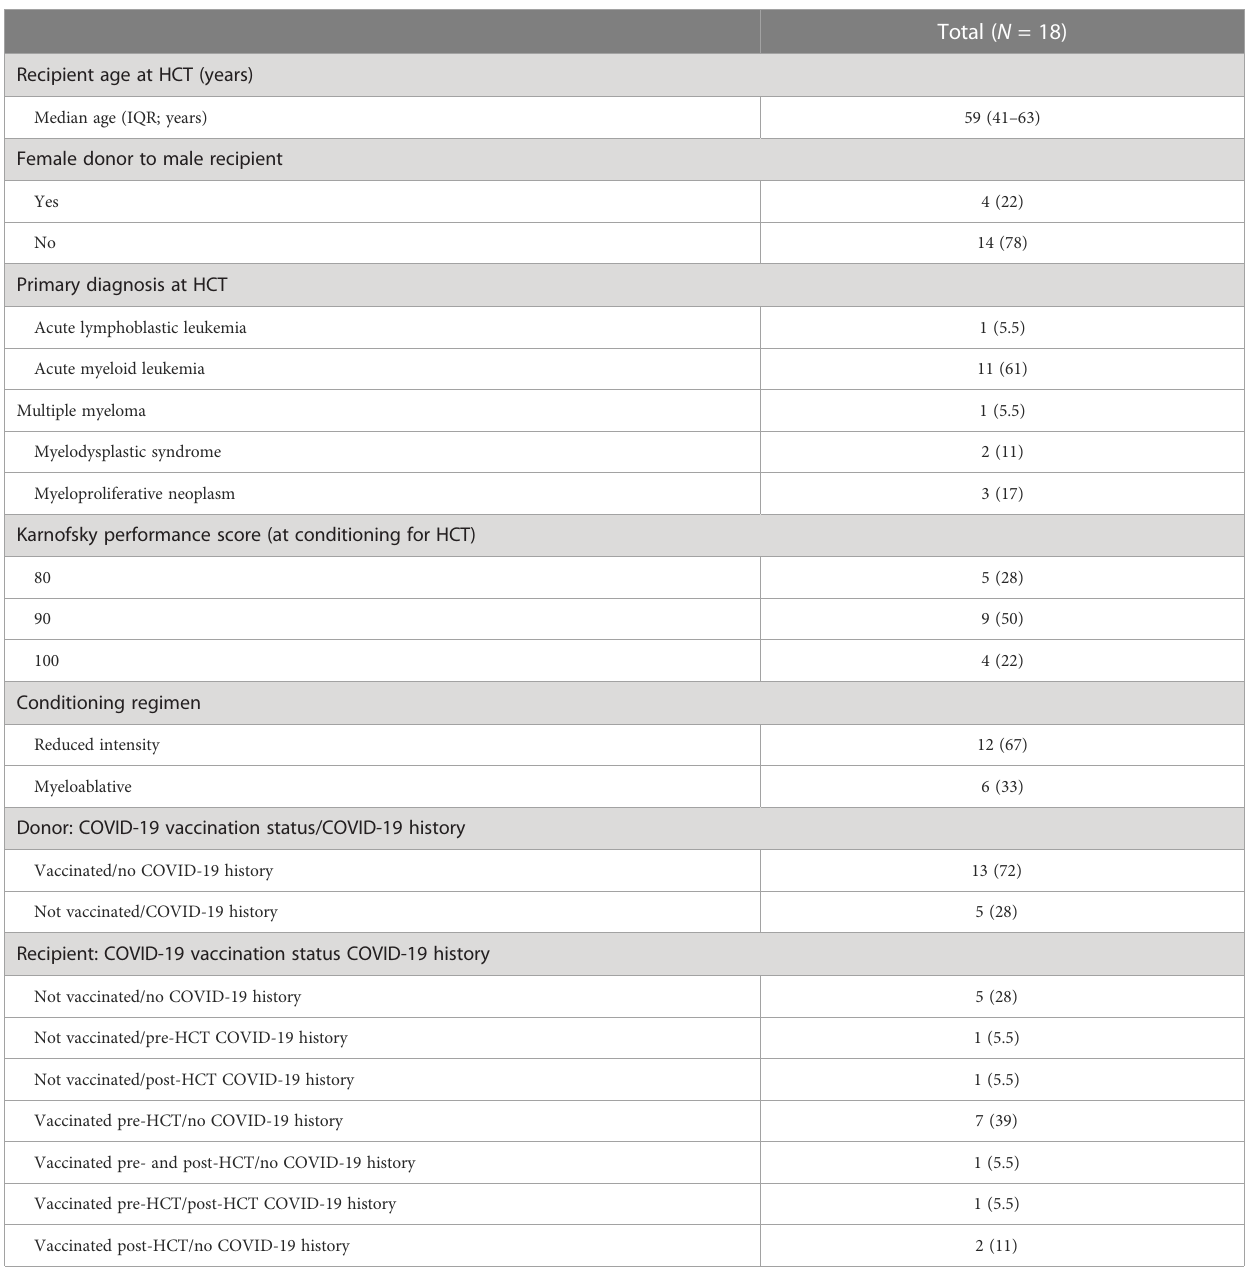
TABLE 1 Characteristics of the study HCT donor/recipient